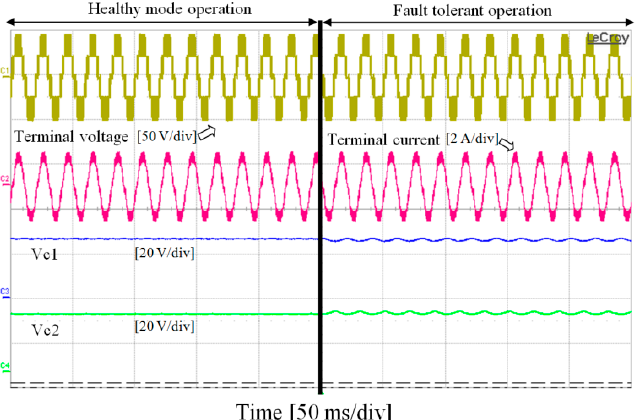
Figure 10. Experimental results of the inverter operation under fault event in D c4 without fault-tolerant control.